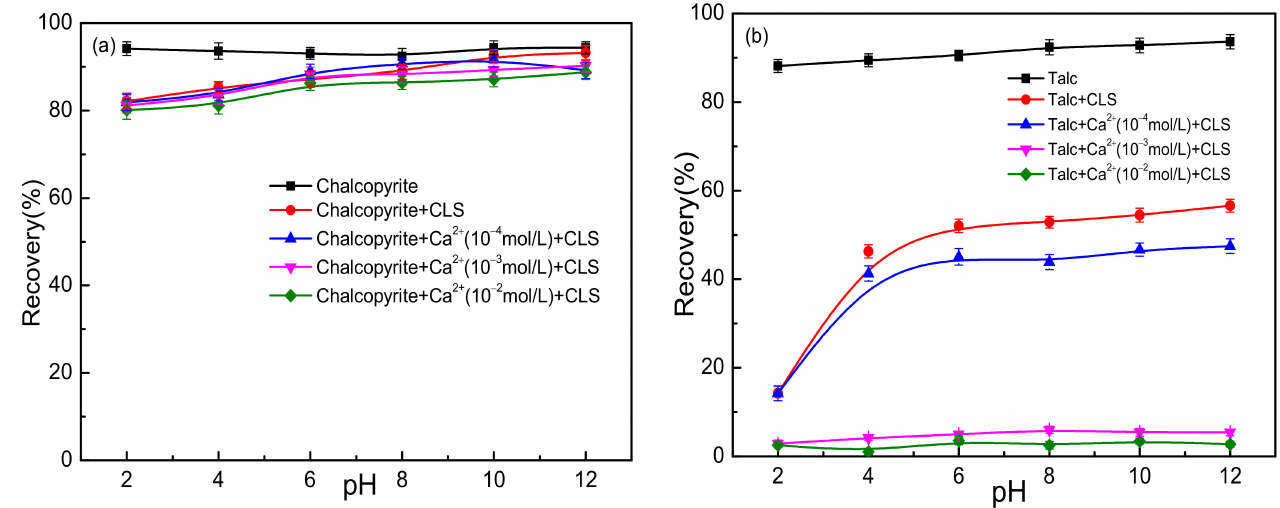
Figure 6. Effect of pH on depression effect of CLS on chalcopyrite( a ) and talc ( b ) in the presence of various Ca 2+ ions (c(CLS) = 200 mg/L, c(PBX) = 50 mg/L, c(MIBC) = 0.125